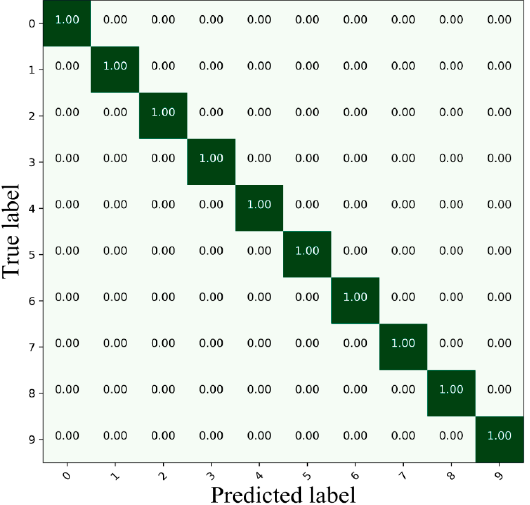
Figure 6. Visual presentation of the last output layer.